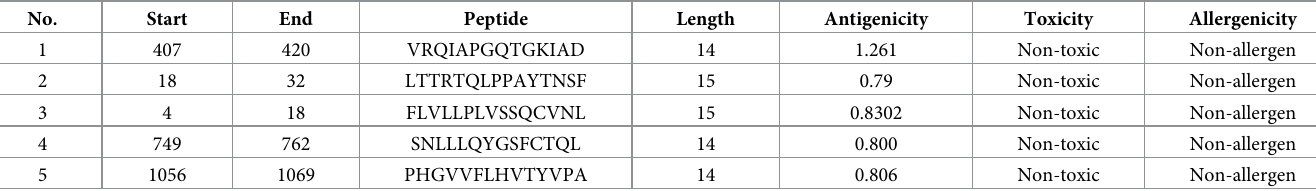
Table 1. B cells linear epitopes of SARS-CoV-2 spike glycoprotein and their immunogenic properties.